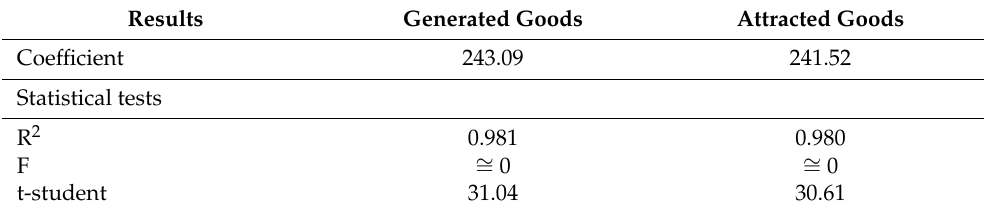
Table 2. Results and statistical tests. Results Generated Goods Attracted